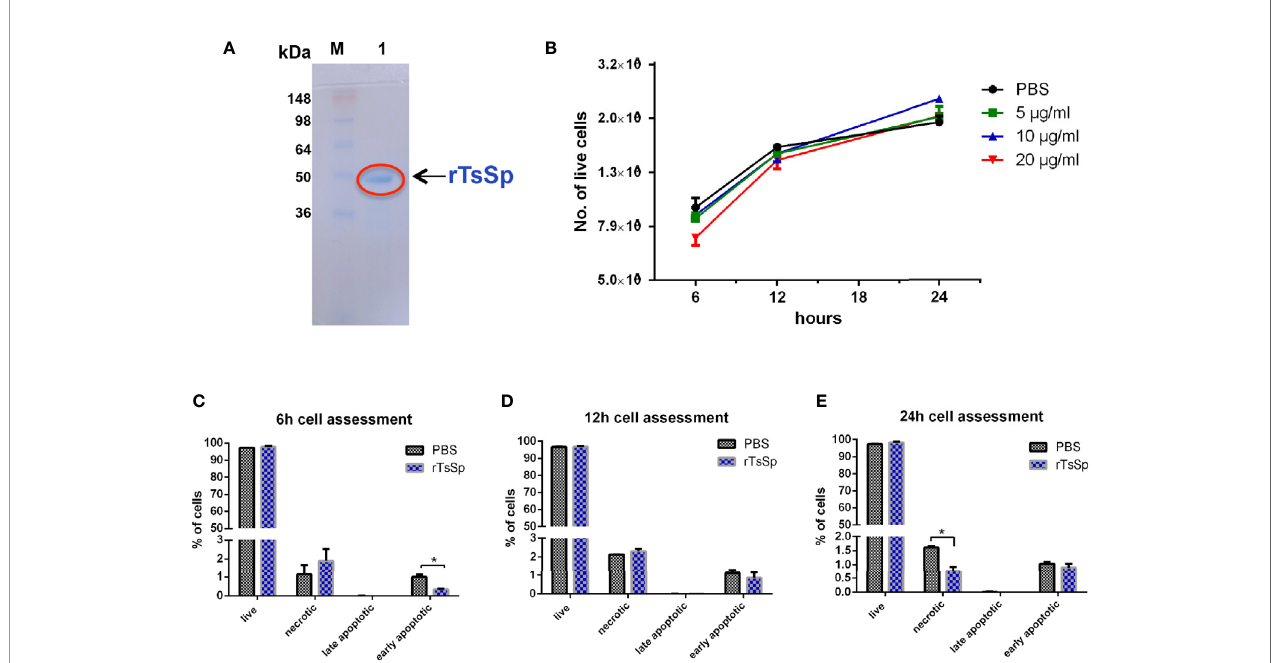
FIGURE 2 | Cytotoxicity assay for the rTsSp. (A) SDS-PAGE analysis of rTsSp protein. M: protein molecular weight marker; 1: rTsSp puri fi ed by Ni-NTA Spin Kit. (B) Cell viability testing with trypan blue exclusion: Raw264.7 cells were treated with different concentrations of the rTsSp in different time points, then collected and analyzed using Countess Automated Cell Counter. (C – E) FAM-FLICA in vitro caspase detection: Raw264.7 cells were treated with 10 m g/ml rTsSp in different time points, then collected and stained with fl uorochrome-labeled inhibitors of caspases (FLICA) and Propidium Iodide (PI). Stained Cells were analyzed on the BD FACSCanto. Four populations of cells were detected: FLICA - PI - indicated unstained live cells; FLICA - PI + necrotic cells; FLICA + PI + cells in late apoptosis; FLICA + PI - cells in early apoptosis. The data shown are means ± SEM from three separate experiments. * P <